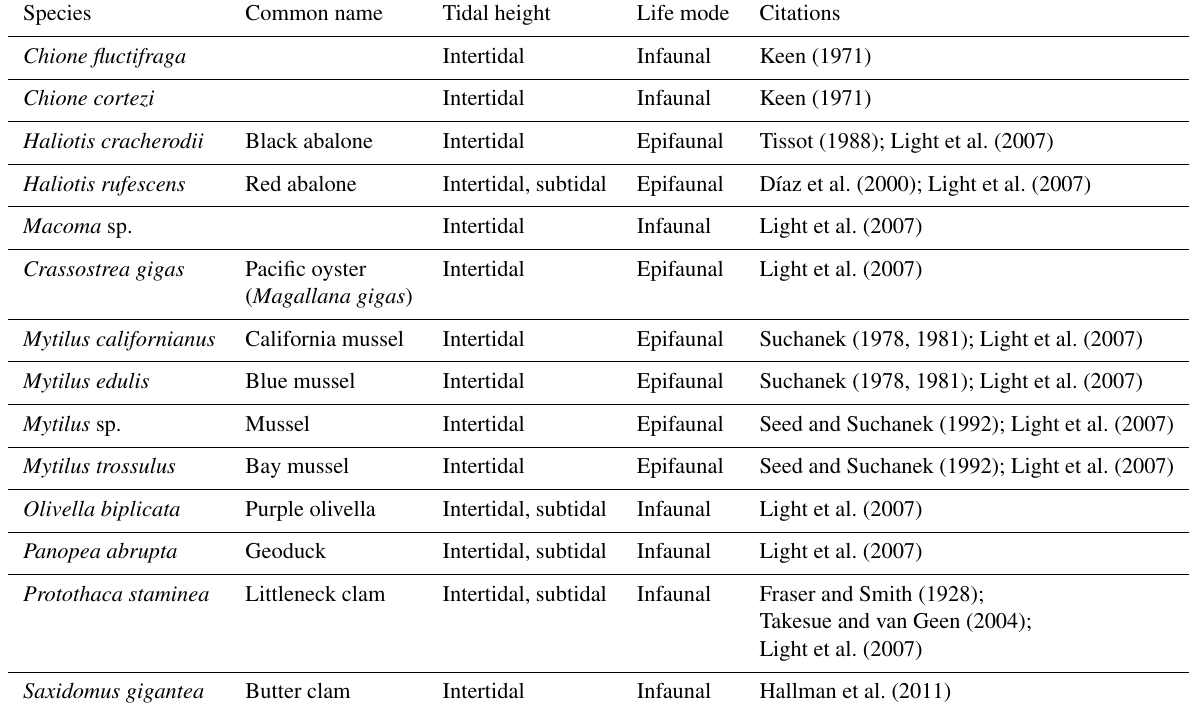
Table 1. Common name, tidal height, and life mode for all taxonomic groups included in the